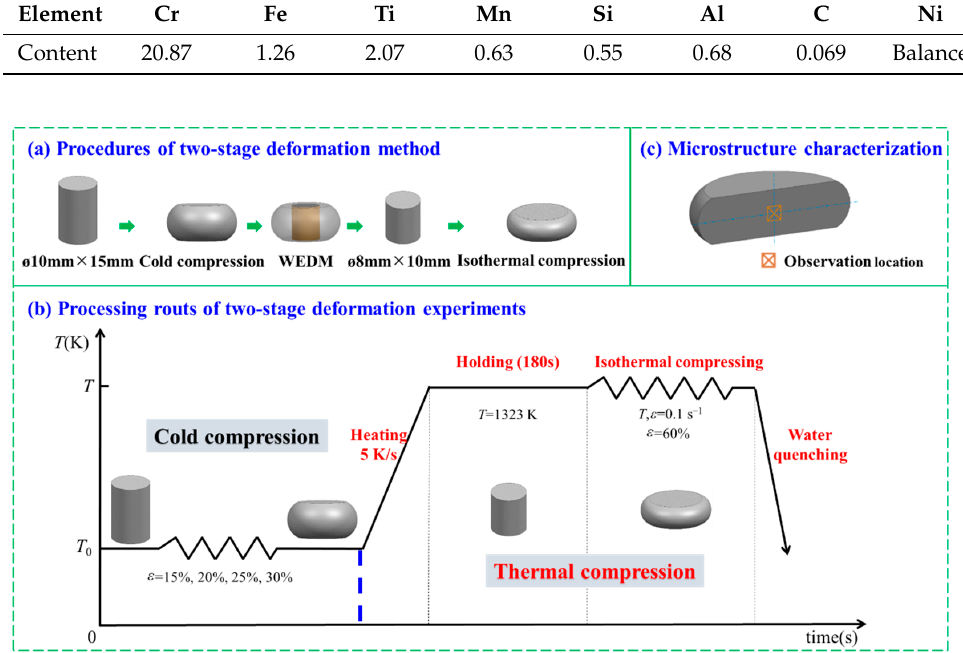
Figure 1. Schematic illustration of the two-stage deformation method and its processing routs. Afterwards, all of the deformed specimens were symmetrically sectioned into two